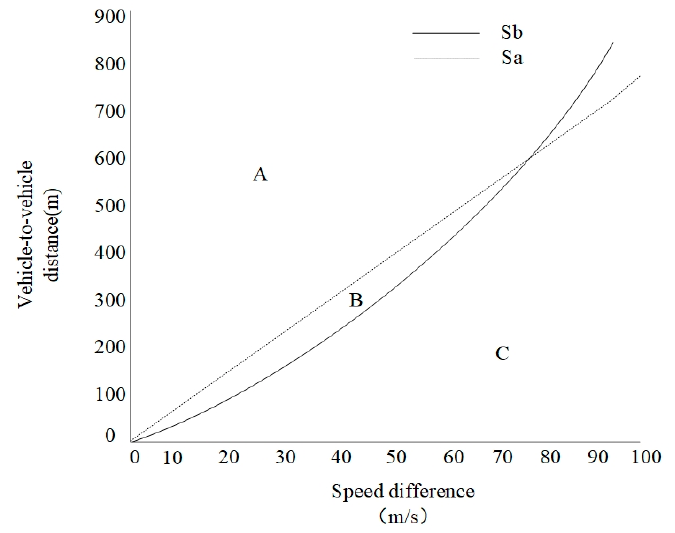
Figure 8. Function of warning level model.